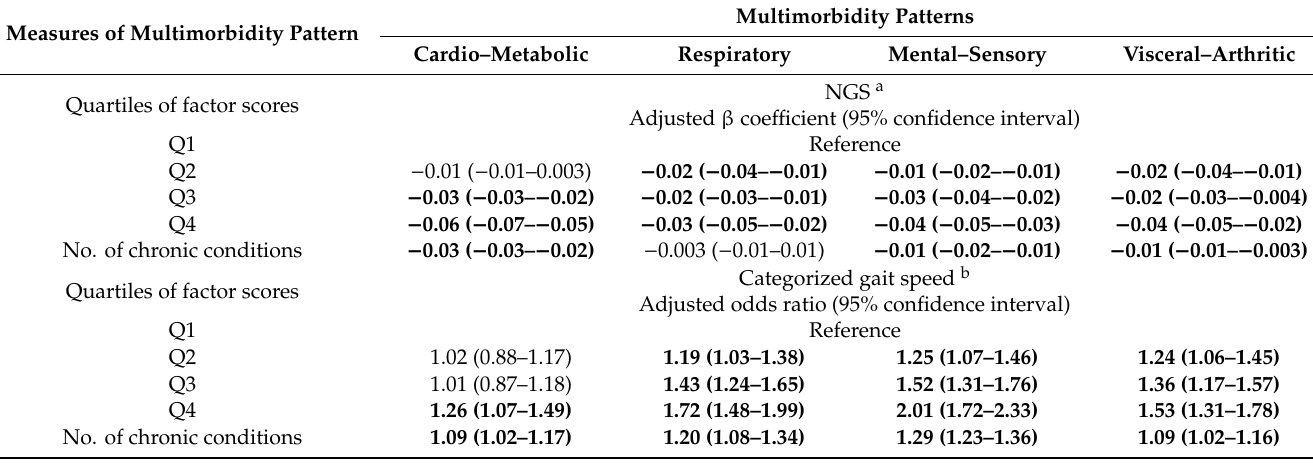
Table 5. Associations between multimorbidity patterns with physical performance among older Chinese adults (N =